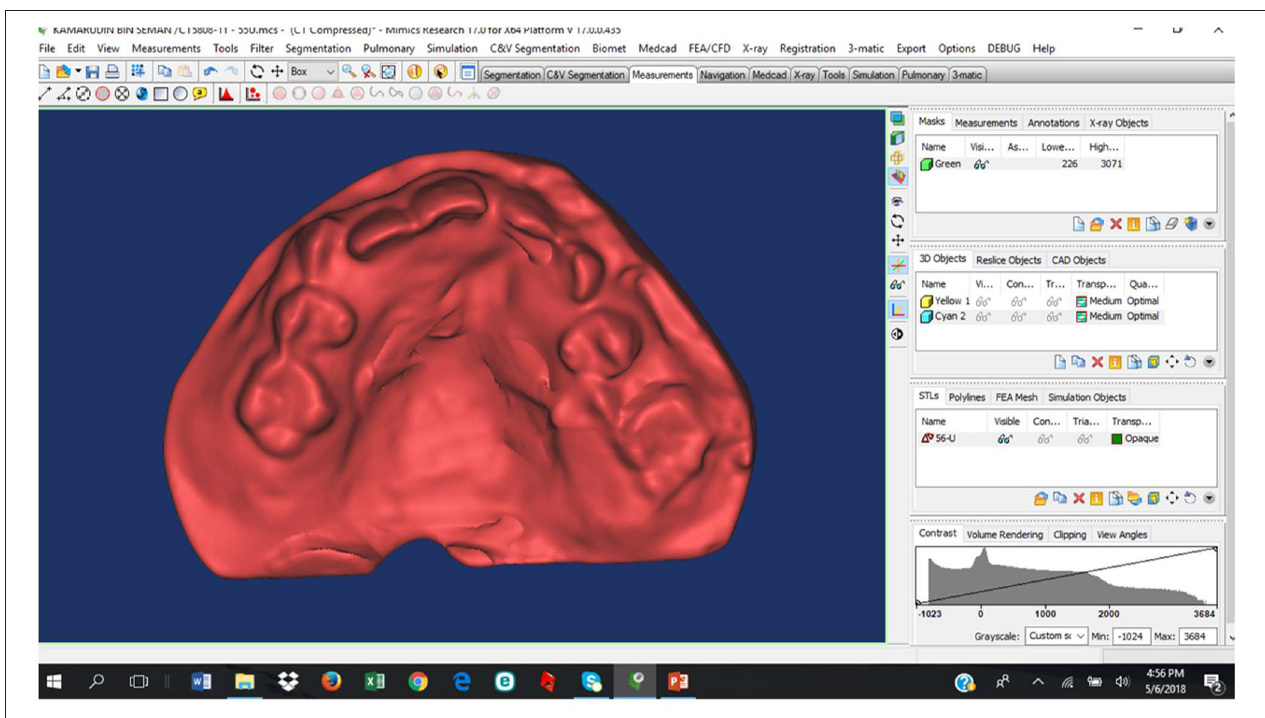
FIGURE 4 | LS3DM in the STL